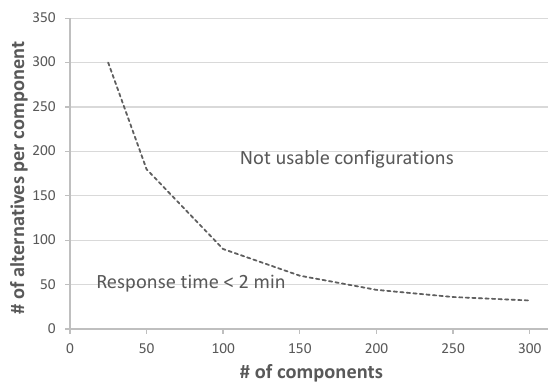
Fig. 8. Region of possible system configurations for which the verification completes within a given